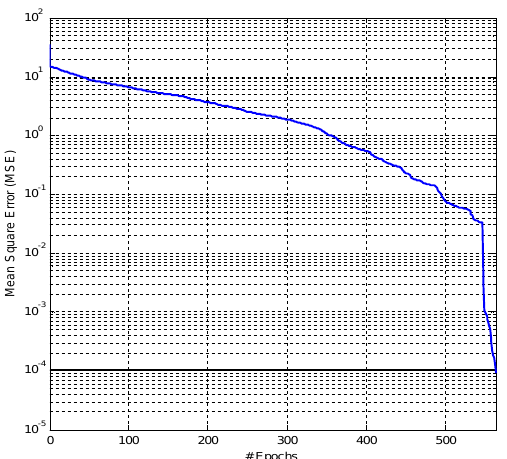
Figure 11 Training Curve for monthly basis using MLP-NN model Fig. 11. Training curve for monthly basis using the MLP-NN model.